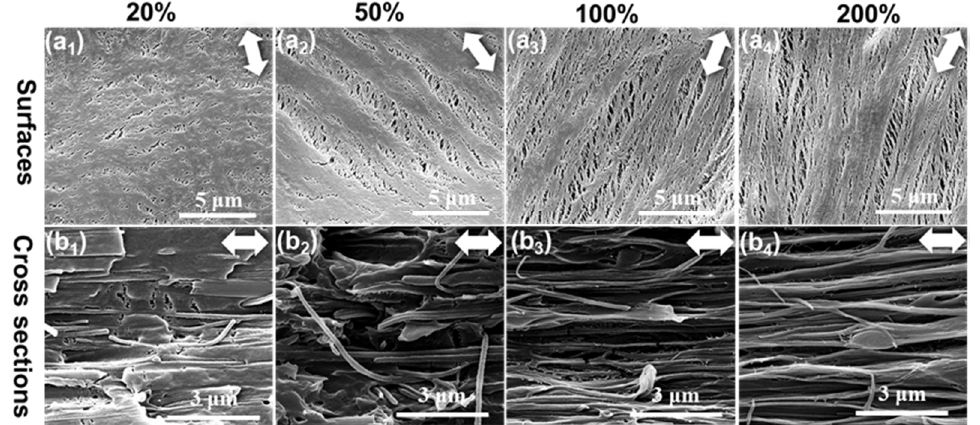
Figure 6. SEM images of the ( a1 – a4 ) surface and ( b1 – b4 ) cross-section microporous structure of PA6/PP(F) films during longitudinal stretching. The tensile temperature was 100 °C and the tensile strains were ( a1 , b1 ) 20%, ( a2 , b2 ) 50%, ( a3 , b3 ) 100%, and ( a4 , b4 ) 200%. The white double arrow represents the direction of stretching.